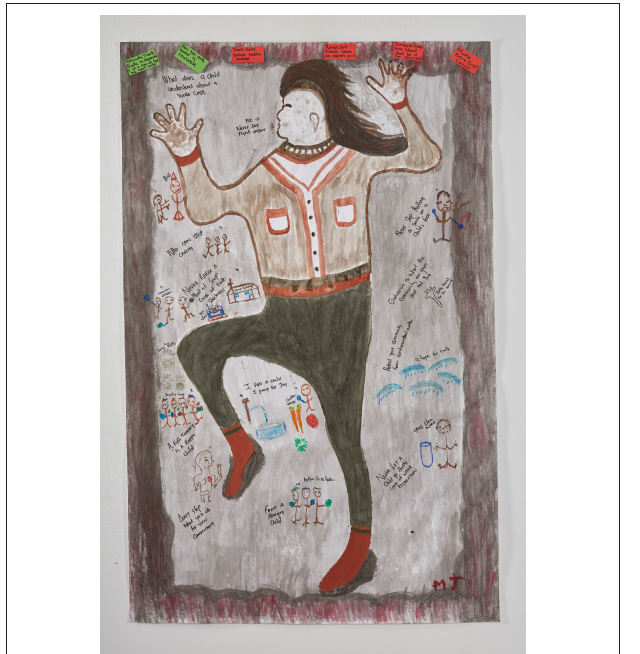
FIGURE 2 | A hand map produced by a PhD student during a planning meeting with the engagement team at SLF; the fingers show five key factors influencing the student’s decision to become a water